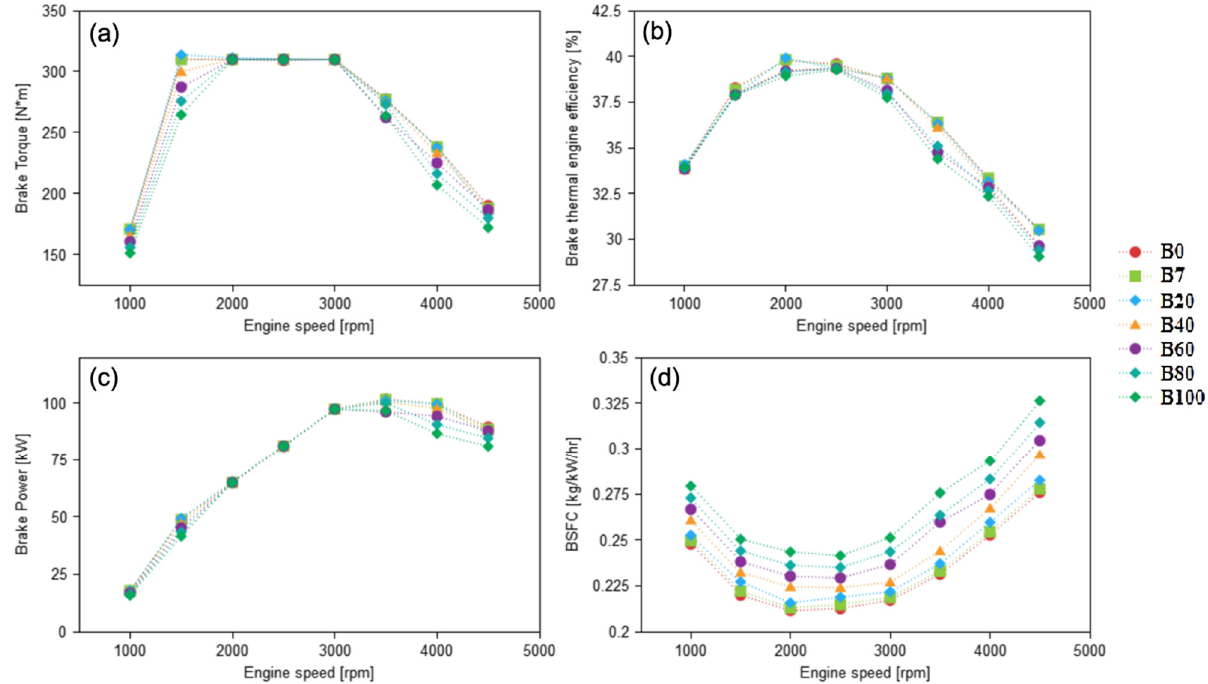
Figure 9. Comparison of ( a ) brake torque, ( b ) BTE, ( c ) brake power and ( d ) BSFC, with different diesel–biodiesel blends.